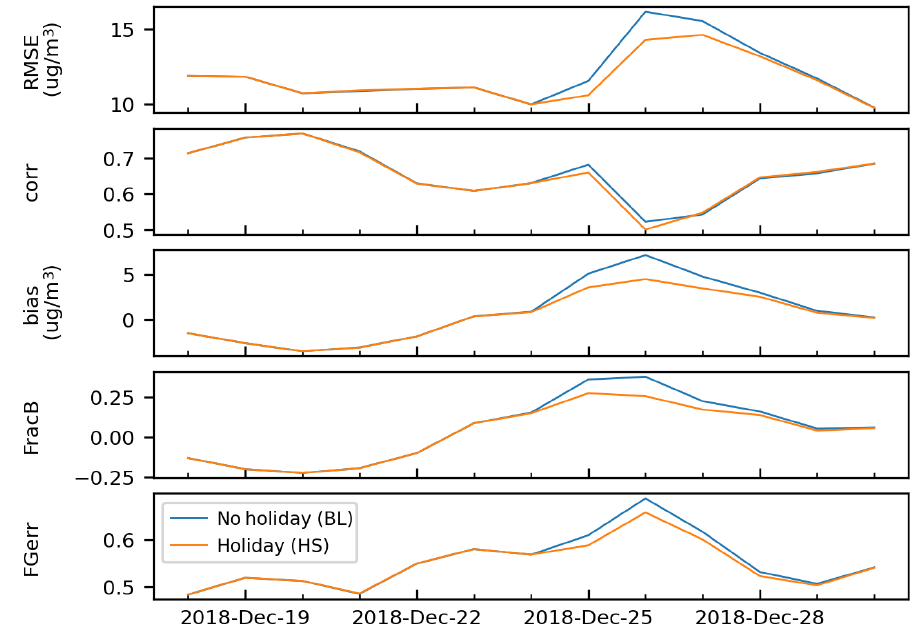
Figure 3. SILAM daily-mean spatial scores for Christmas (NO 2 , all of